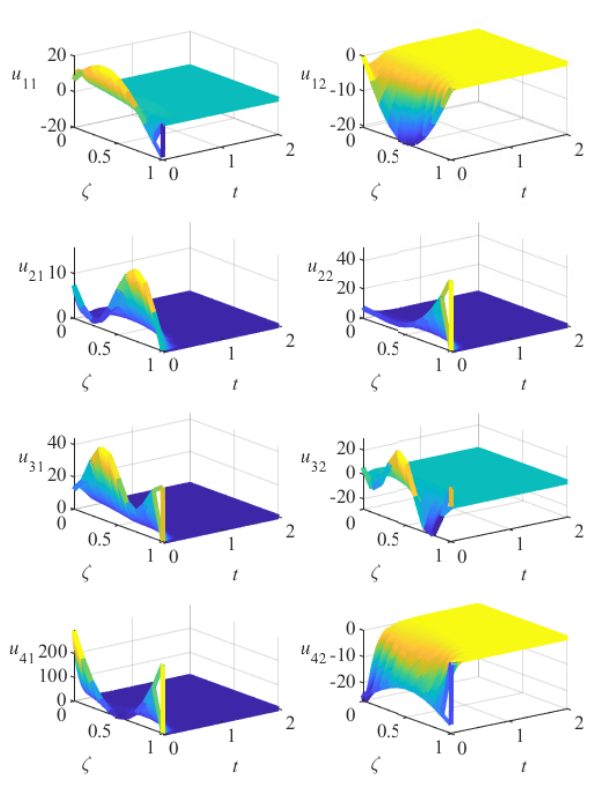
Figure 3. The control input of HPDECSTN